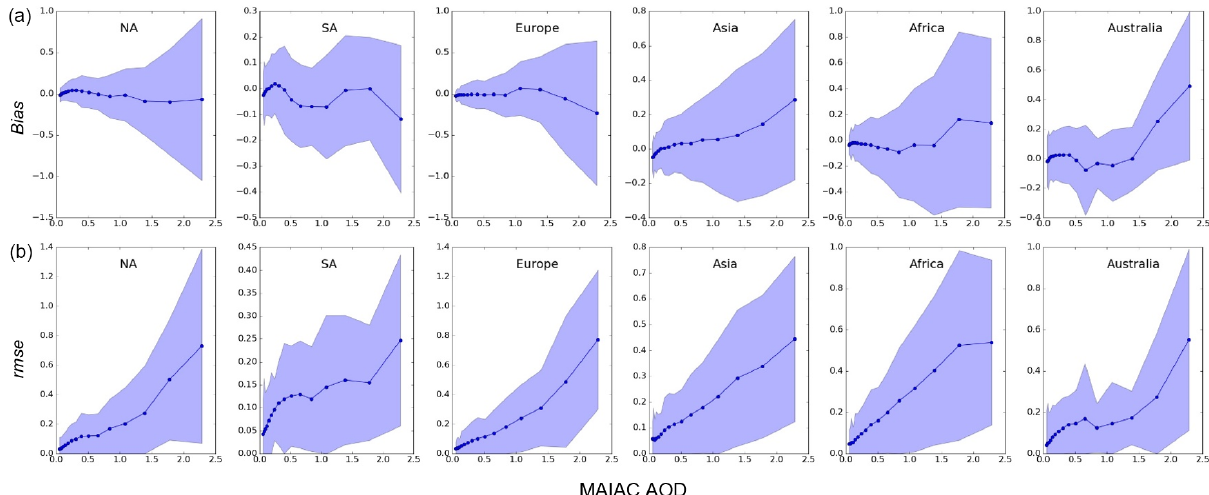
Figure 8. Bias (a) and RMSE (b) of MAIAC AOD for different world regions as a function of retrieved AOD. NA and SA stand for North and South America.